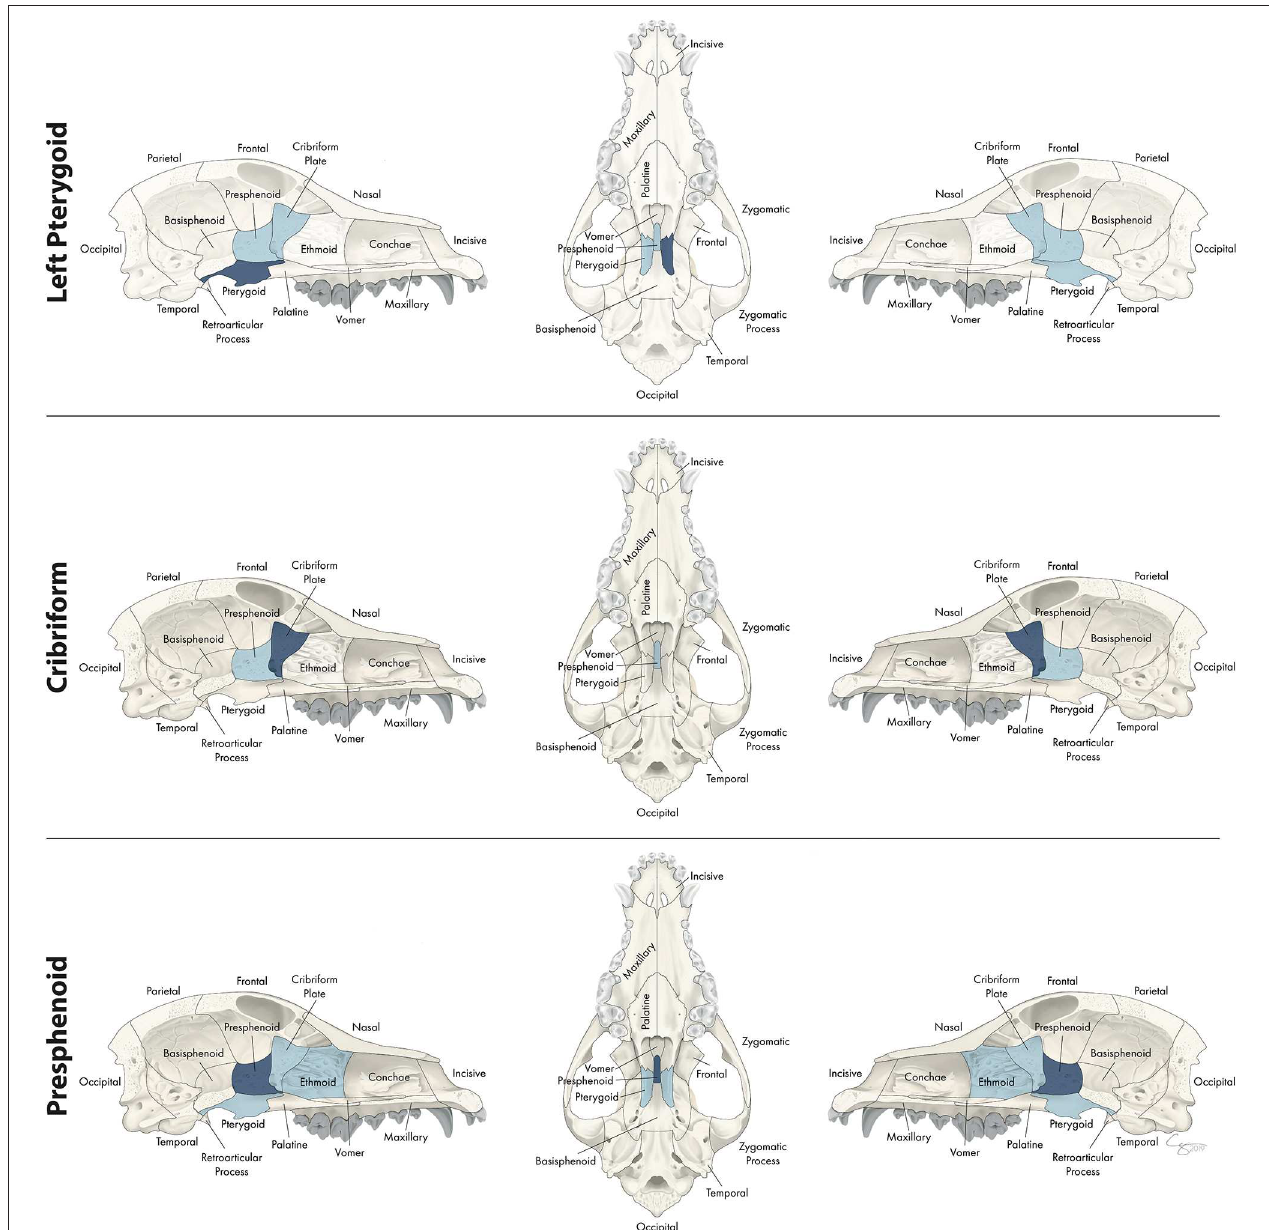
FIGURE 12 | Significant bones or regions fractured concurrently with the pterygoid, cribriform plate, and presphenoid bone. When the pterygoid bone was the region of interest, the cribriform plate, presphenoid bone, and contralateral pterygoid bone fractured concurrently. When the cribriform plate was the region of interest, the presphenoid bone fractured concurrently. When the presphenoid bone was the region of interest, the cribriform plate, ethmoid bone, and bilateral pterygoid bones fractured concurrently. Although the left pterygoid bone is shown, when the right pterygoid bone was the region of interest, a mirror image of concurrently fractured locations applied. Only views of the skull that demonstrate a fractured region are